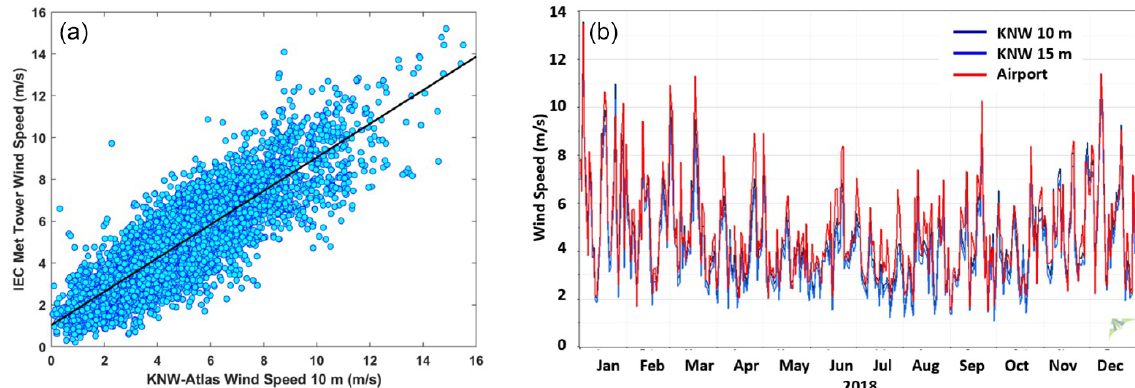
Figure 2. Panels (a) and (b) show the approximate accuracy of the KNW-Atlas reanalysis data in the study region. Panel (a) compares reanal- ysis data at 10m (no vertical interpolation) with those data collected from the IEC meteorological tower. A small negative bias ( − 0 . 12ms − 1 ) is observed with an R 2 of 0.75. Panel (b) compares the KNW reanalysis data product to data from the Amsterdam Schiphol Airport in 2018 using the nearest KNW site (14km